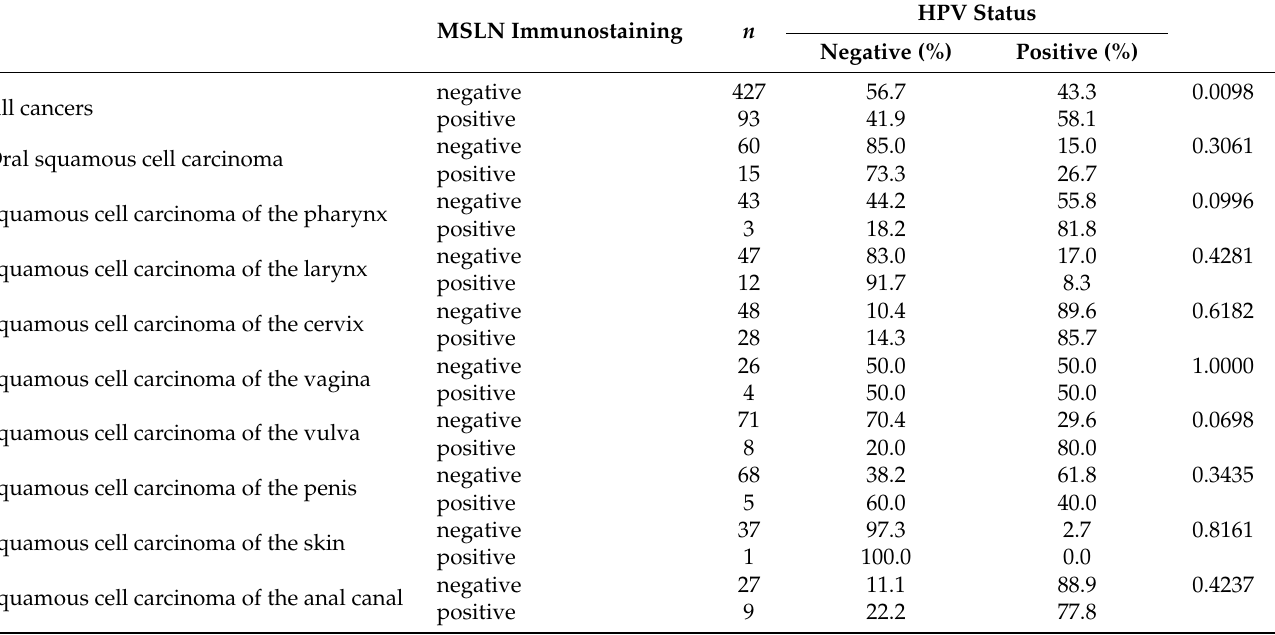
Figure 4. MSLN immunostaining and patient prognosis. All bladder cancer patients had at least pT2 cancers and were treated by cystectomy. Table 3. MSLN immunostaining and HPV status.